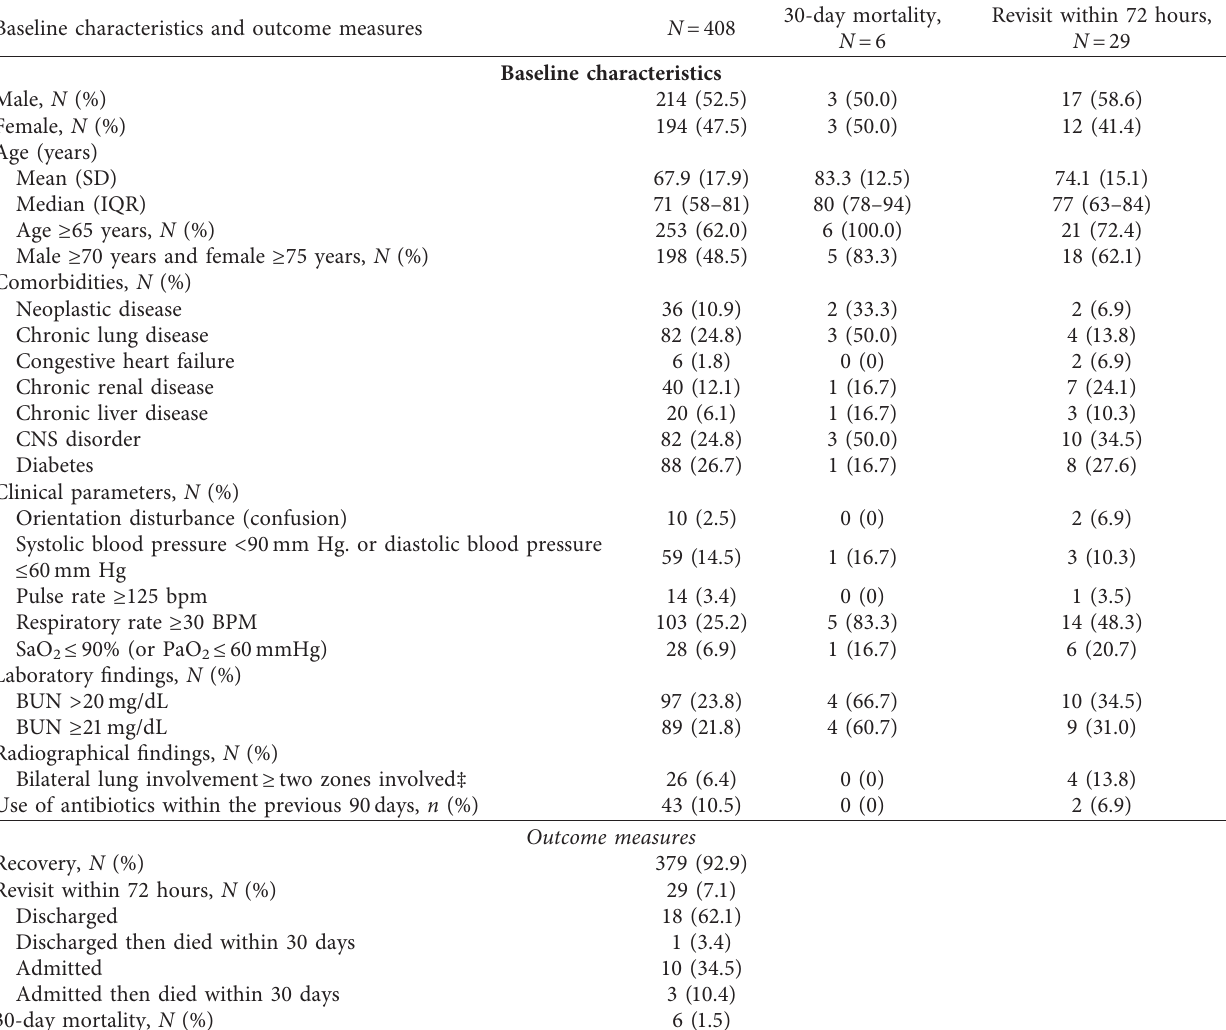
Table 1: Baseline characteristics and outcome measures in patients with community-acquired pneumonia.